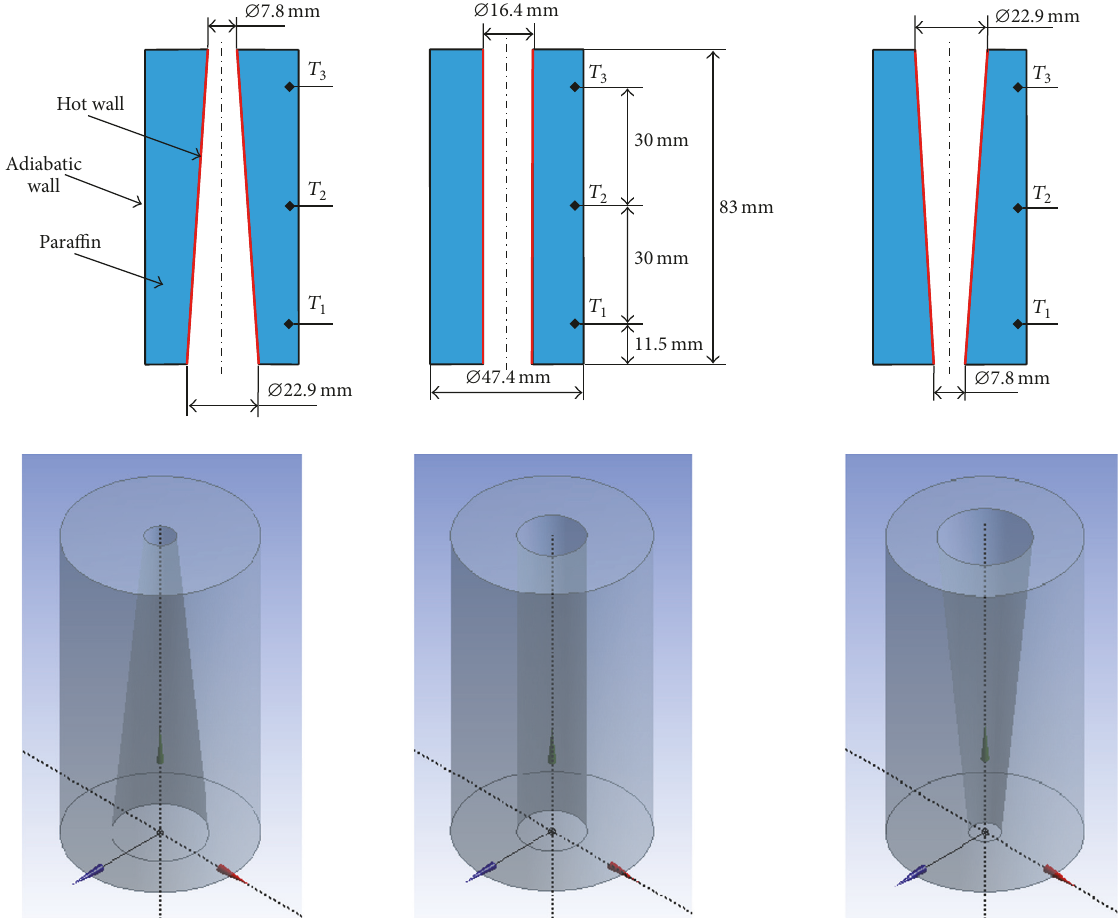
Nozzle-and-shell model Tube-and-shell model Reducer-and-shell Figure 2: Model for numerical